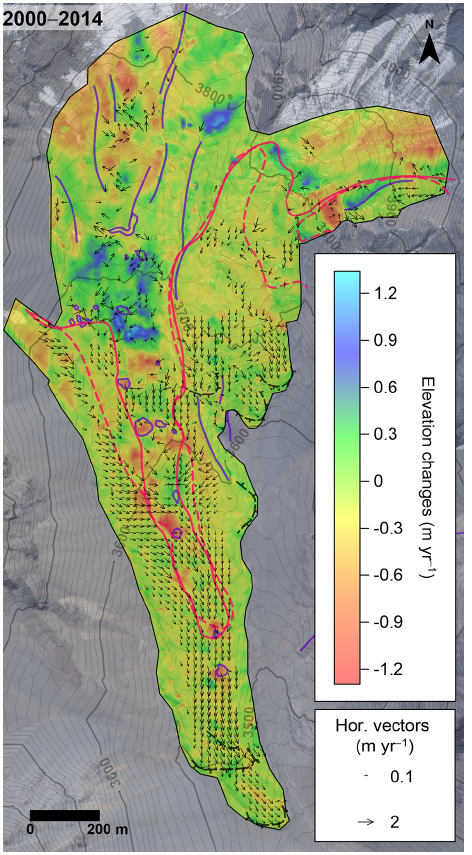
Figure 9. Horizontal displacements at the surface of Navarro be- tween 1955 and 2000. The boundary between debris-covered and rock glacier morphology is depicted with a dotted red line in 1955 and with a dashed red line in 2014. Note that moraine crests and thermokarst depressions in 2000 are indicated. The background of the map is the 2000 orthophoto.